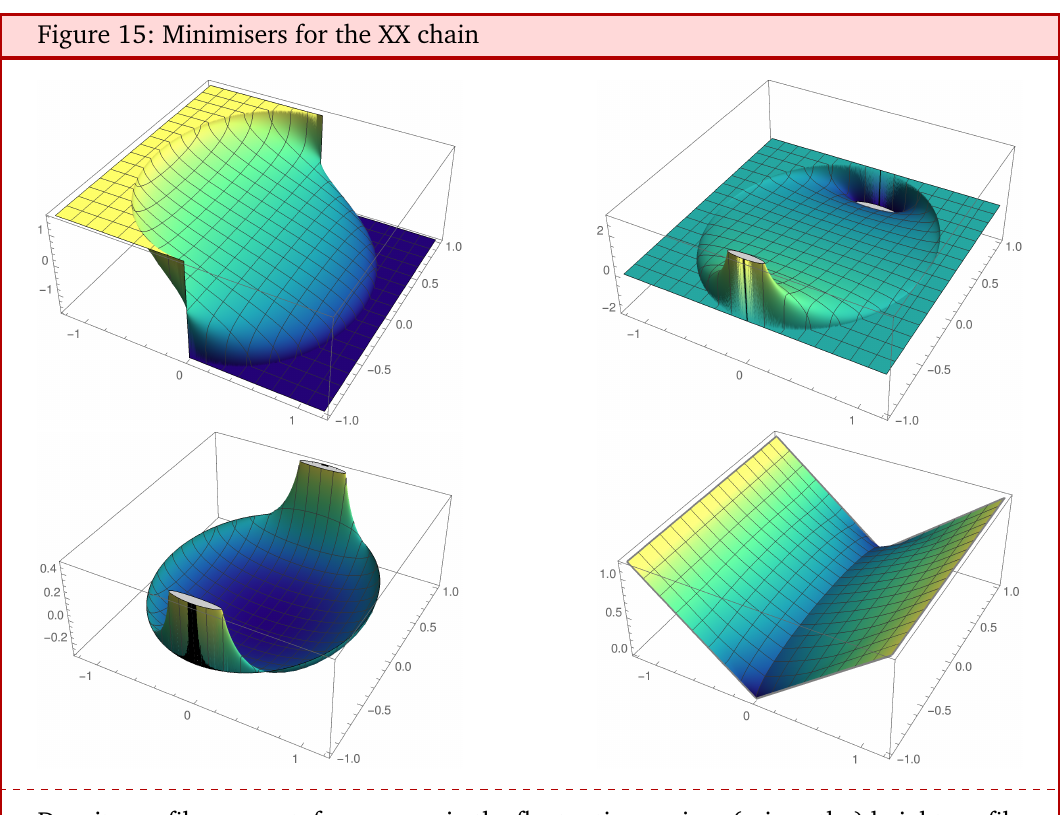
Figure 15: Minimisers for the XX